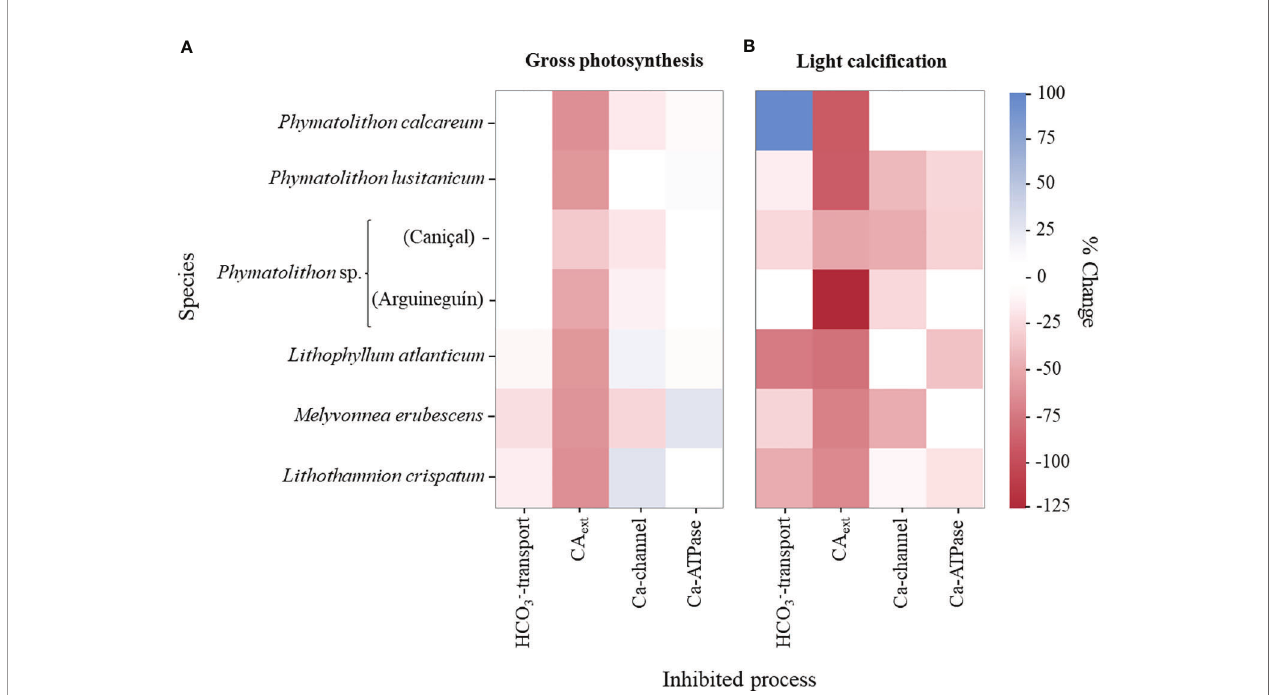
FIGURE 7 | Importance of external carbonic anhydrase and speci fi c ion transporters for rhodolith physiological processes. Heat maps indicate the effects of inhibition of speci fi c processes on (A) maximum gross photosynthesis and (B) light calci fi cation in different rhodolith species, expressed as signi fi cant changes before and after the inhibitor treatment (paired sample t -test, p<0.05, Supplementary Tables S3, S4